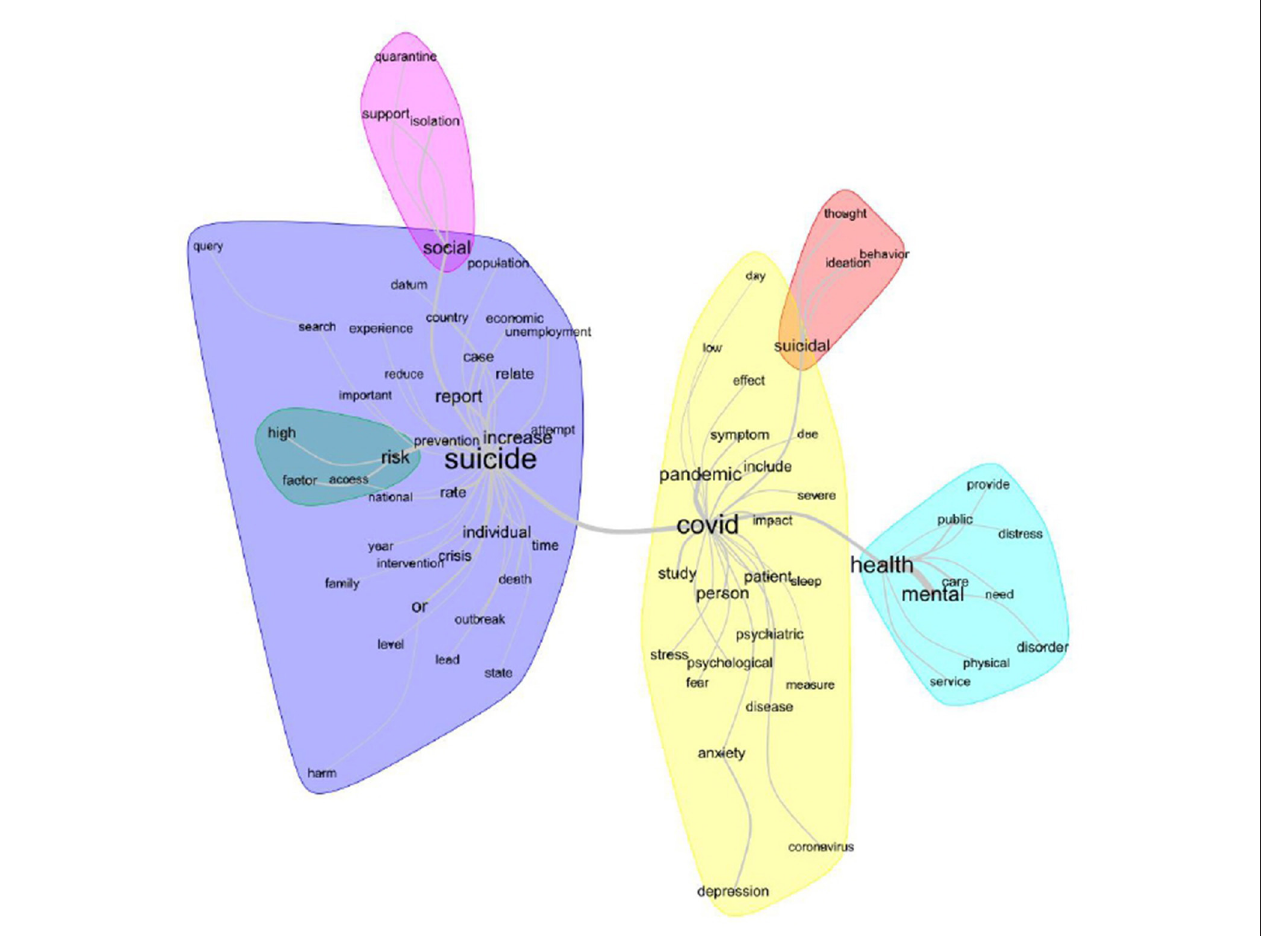
FIGURE 3 | Lexical similarity analysis